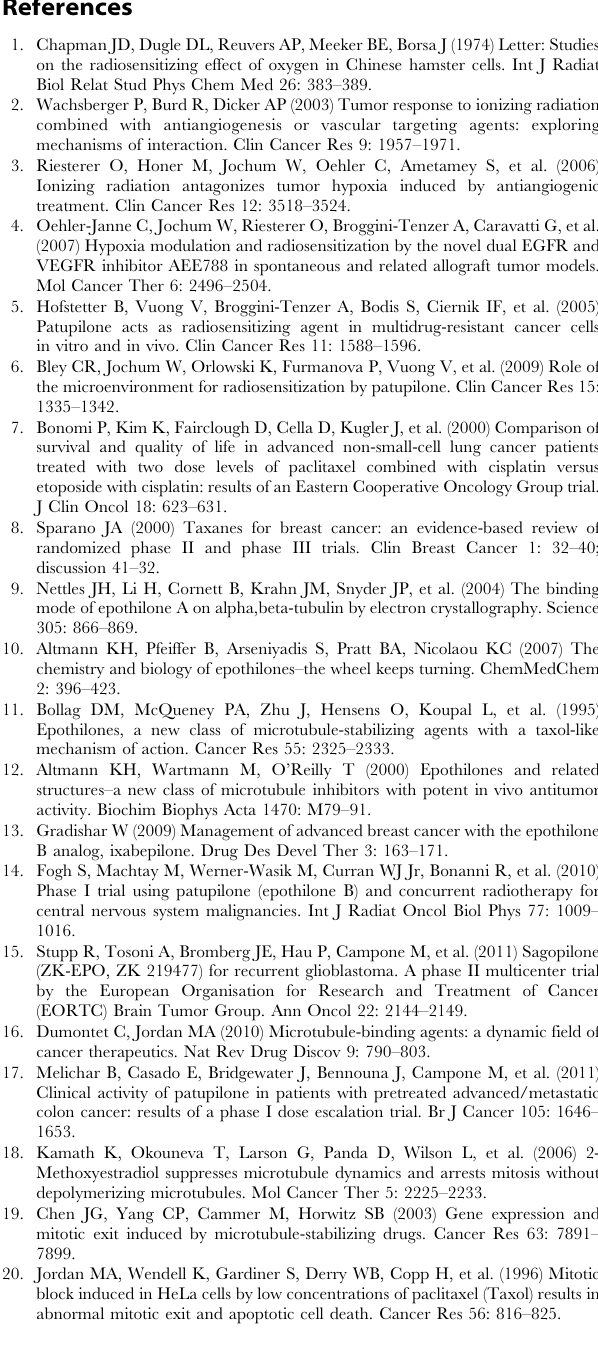
Figure S4 Clonogenic cell survival after treatment with patupilone and IR of A549 ODD-Luc cells. Cells were treated with placebo or patupilone for 18 hours followed by an immediate clonogenic survival assay in response to irradiation, or preincubated with patupilone for 18 hours followed by 7 days of cultivation in absence or presence of patupilone, followed by a delayed clonogenic survival assay in response to irradiation. Error bars represent mean 6